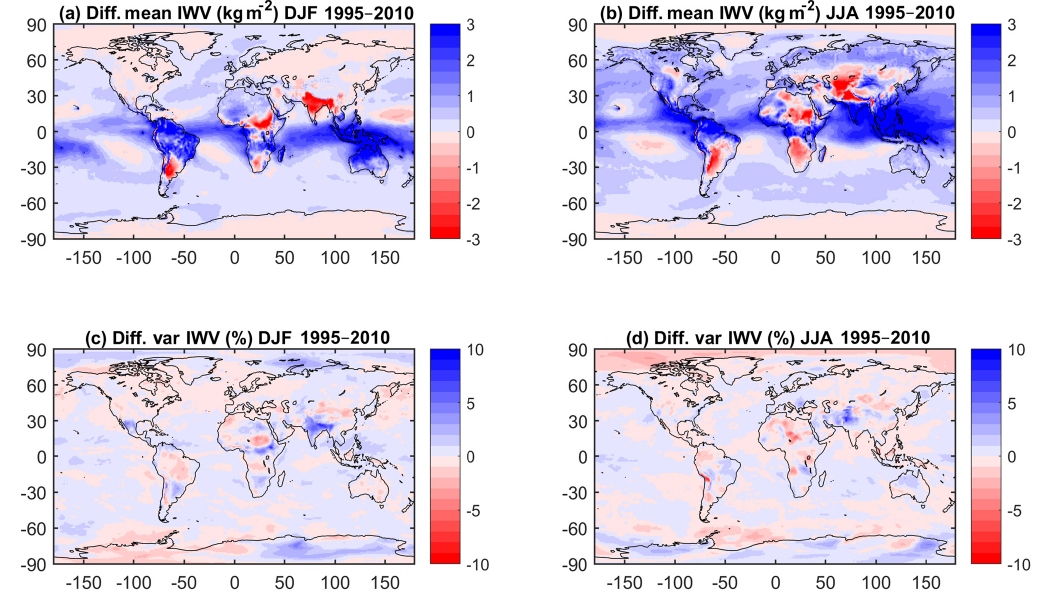
Figure 3. (a) Difference of mean IWV estimates (MERRA-2 minus ERA-Interim) for DJF 1995–2010. The global mean difference is 0.35kgm − 2 (0.94%) and the standard deviation of the difference is 0.32kgm − 2 (1.56%). (b) Same as panel (a) for JJA. The global mean difference is 0.56kgm − 2 (1.66%) and the standard deviation of the difference is 0.37kgm − 2 (1.67 %). (c) Difference of relative variability estimates (MERRA-2 variability minus ERA-Interim variability) for DJF 1995–2010. The global mean difference is − 0 . 01% and the standard deviation of the difference is 0.26%. (d) Same as panel (c) for JJA. The global mean difference is 0.28% and the standard deviation of the difference is 0.42%.